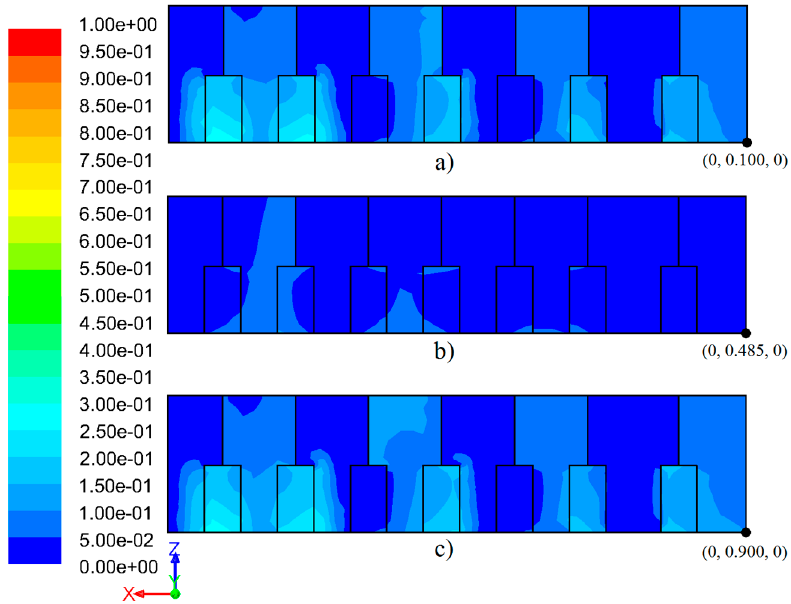
Figure 15. The results of the field of temperature in the x–z plane through the planes: ( a ) y adm = 0.100; ( b ) y adm = 0.485; and ( c ) y adm = 0.900.